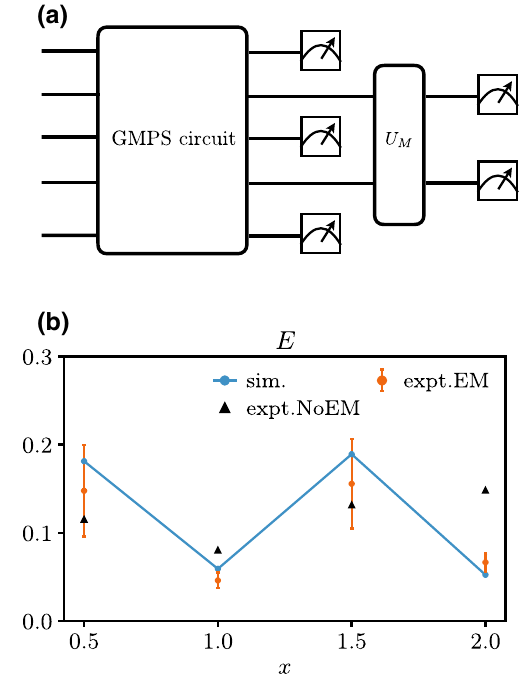
FIG. 8. Error mitigation. (a) To mitigate hardware errors, we postselect on results with the correct total particle number. To simultaneously measure total particle number and Green’s func- tion elements (cid:4) c † c j (cid:2) , we add a basis transformation gate U M for i the corresponding qubits of Green’s functions before measur- ing them and each qubit is measured in the Pauli- Z basis as in Ref. [20]. In the holographic implementation, the first qubit being measured cannot be reset and reused until both sites i , j are mea- sured. (b) A comparison between measurement results for the QMPS VQE method of U = 6, half-filled Fermi-Hubbard model with (EM) and without (NoEM) the error mitigation. Details of postselection success rate and shot counts are shown in Table